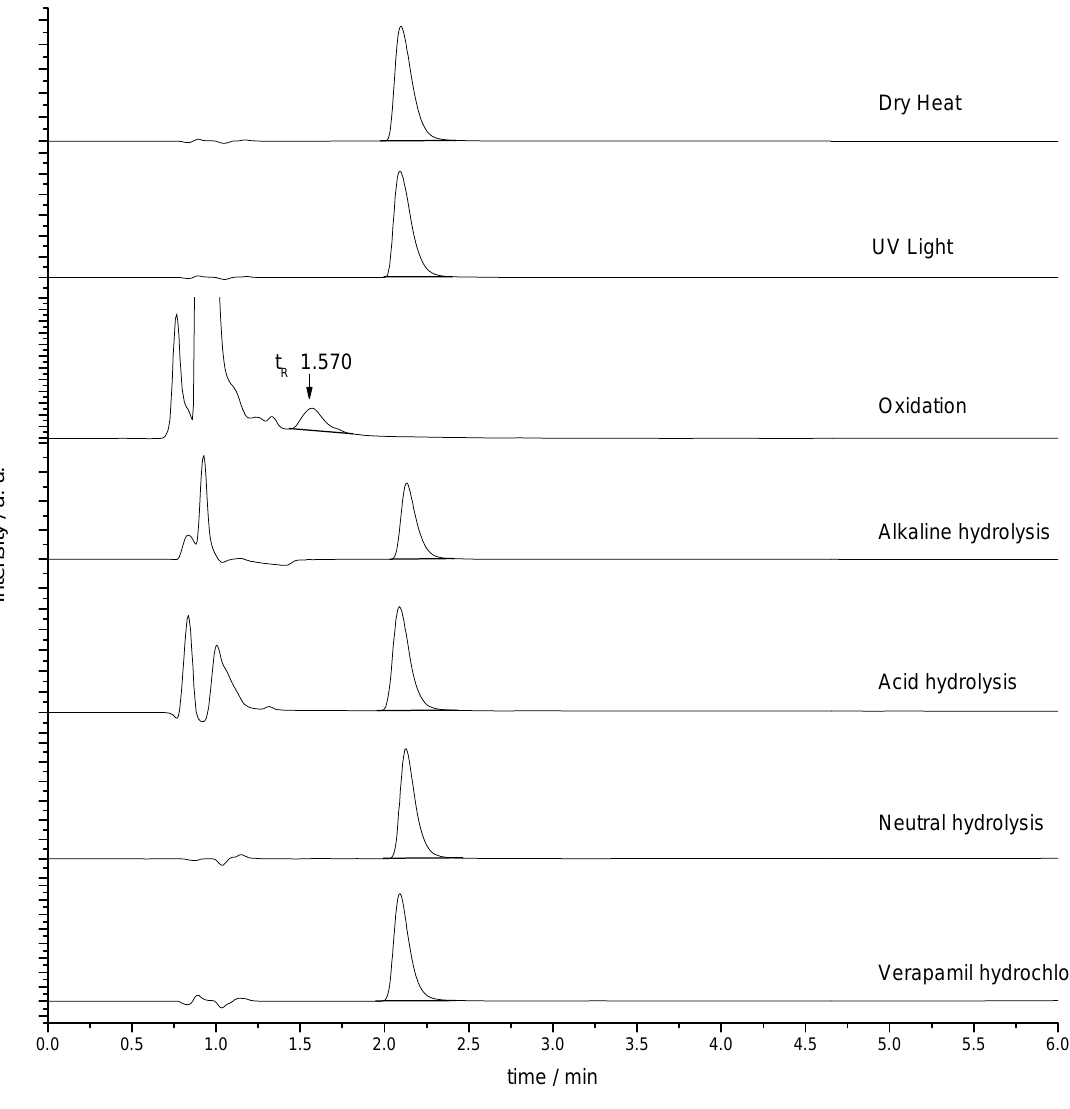
Figure 3. Verapamil hydrochloride chromatogram before (bottom) and after application of diverse stress conditions: neutral hydrolysis; acid hydrolysis; basic hydrolysis; oxidation; exposure to UV light; and exposure to temperature (dry